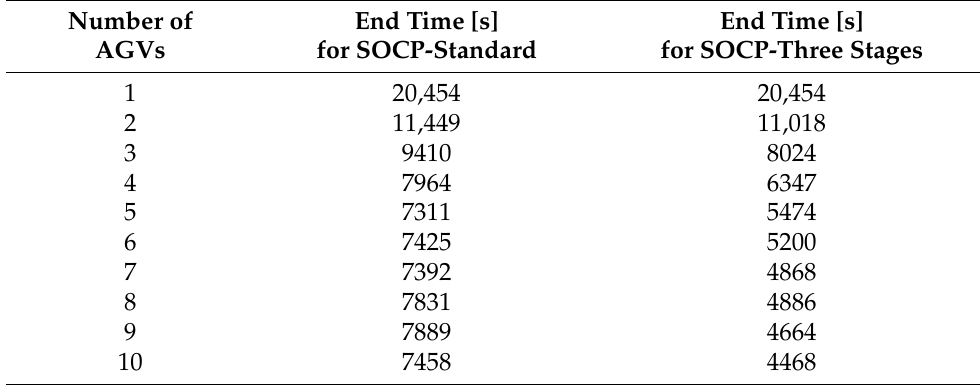
Table 2. The results of the simulation (bidirectional